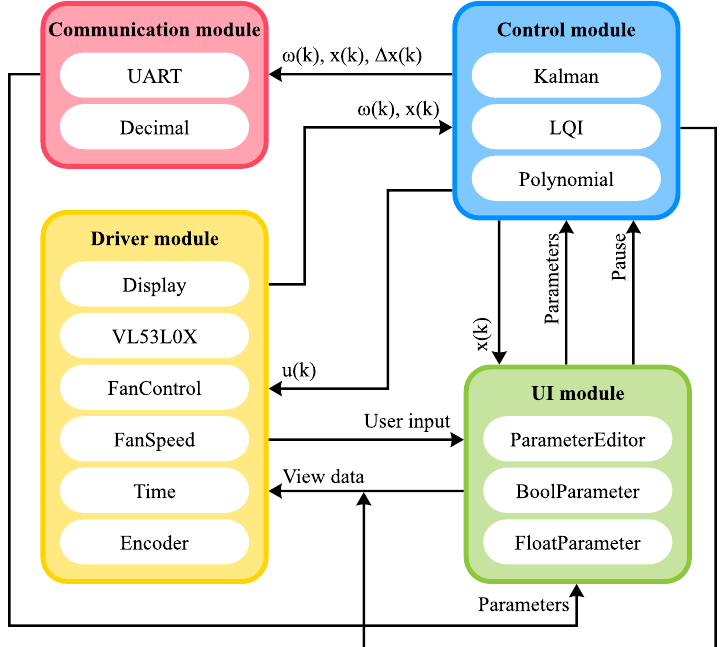
Figure 3. Firmware design